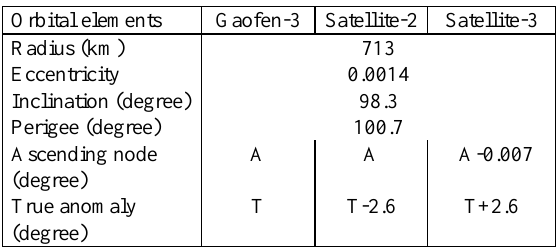
Table 1. Orbit elements of the